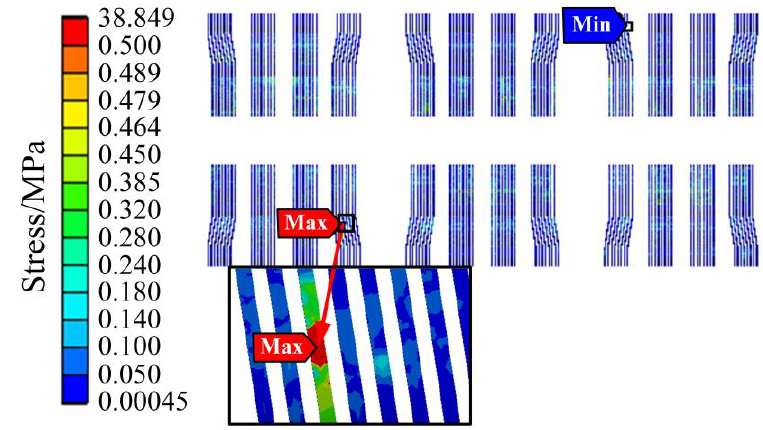
Sensors 2023 , 23 , x FOR PEER REVIEW Figure 15. The stress of bonding wire under the first order mode. Figure 15. The stress of bonding wire under the first order mode.